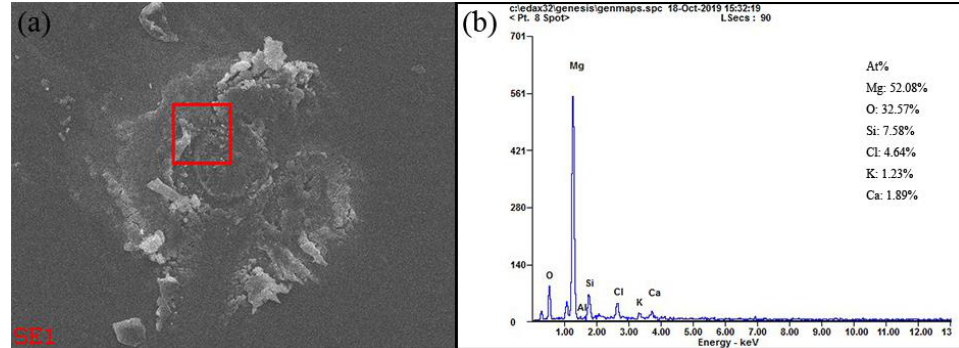
Figure 16. EDS spectrum of combustion residue of individual Mg microparticle, ( a ) The location of EDS analysis area in the residue (in the square box), ( b ) the content of elements, At% represents the percentage of atomic number.